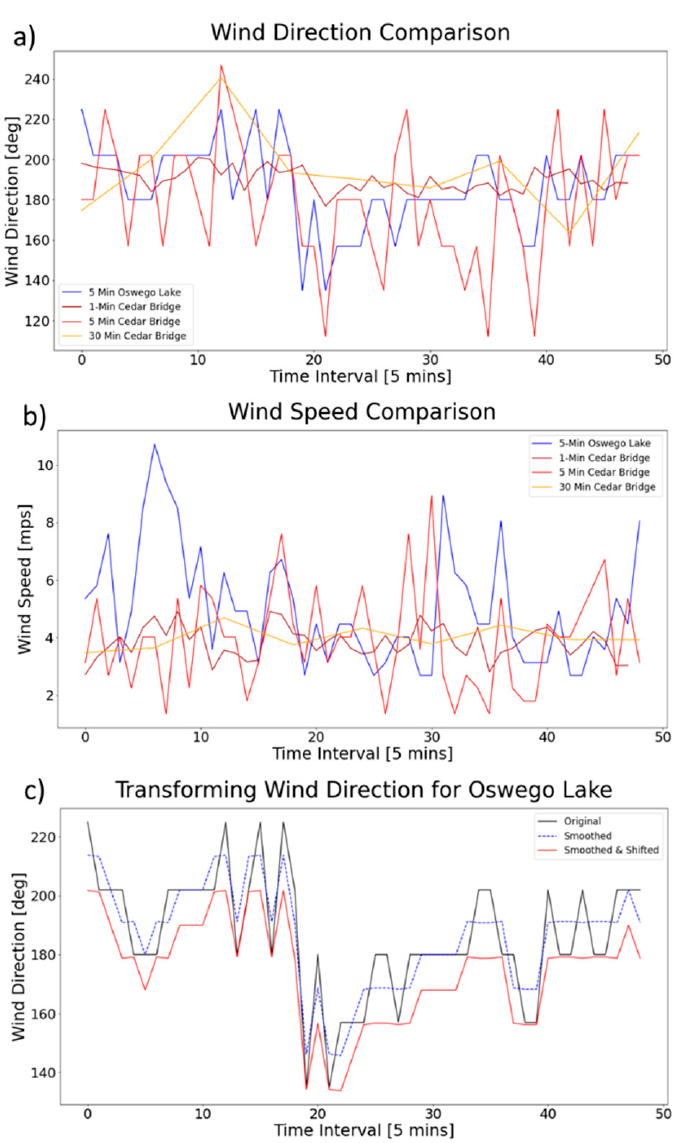
Figure 4. ( a ) Comparison of wind direction data collected at Oswego Lake and Cedar Bridge during the initial four hours of the Spring Hill Fire, ( b ) comparison of wind speed data collected at Oswego Lake and Cedar Bridge during the initial four hours of the Spring Hill Fire, and ( c ) transformations of Oswego Lake’s wind direction data. Original data was smoothed to reduce the dramatic fluctuations in direction due to low reporting precision of direction in the raw data.